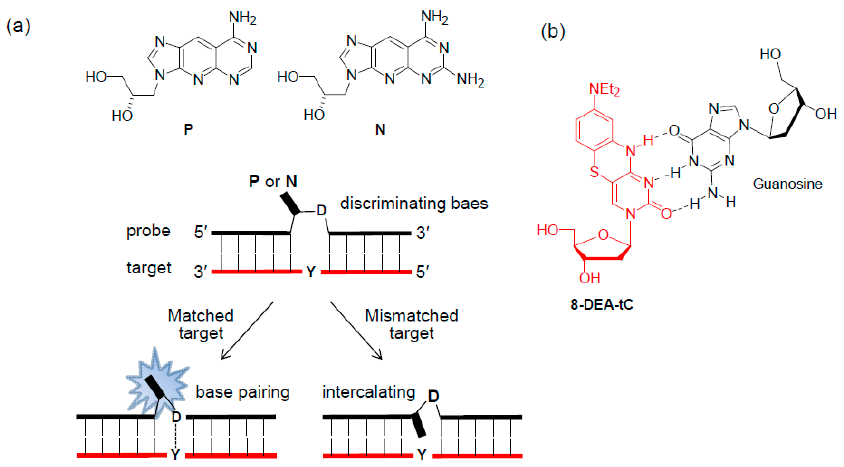
Figure 7. ( a ) Tricyclic base-linked acyclonucleoside, P and N , and ( b ) tricyclic cytidine analog 8-DEA-tC .